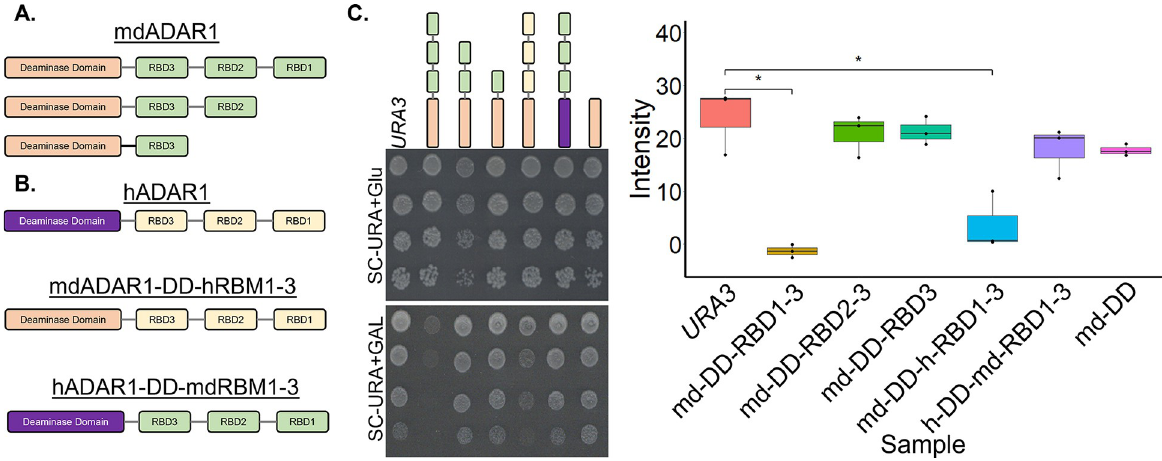
Fig 4. mdADAR1 potency is mainly due to its catalytic domain. (A, B) Schematic representation of the full length mdADAR1, the shorter deletion (A), and the domain swapping constructs tested (B). C. 10-fold serial dilutions of the indicated strains were spotted, and growth was quantitated as described in 1D. Plates were incubated at 30˚C for 40h. Cells carrying an empty URA3 plasmid were used as a control.